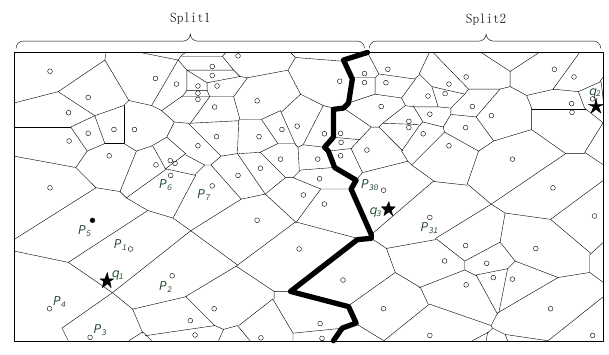
Figure 9. Data partition